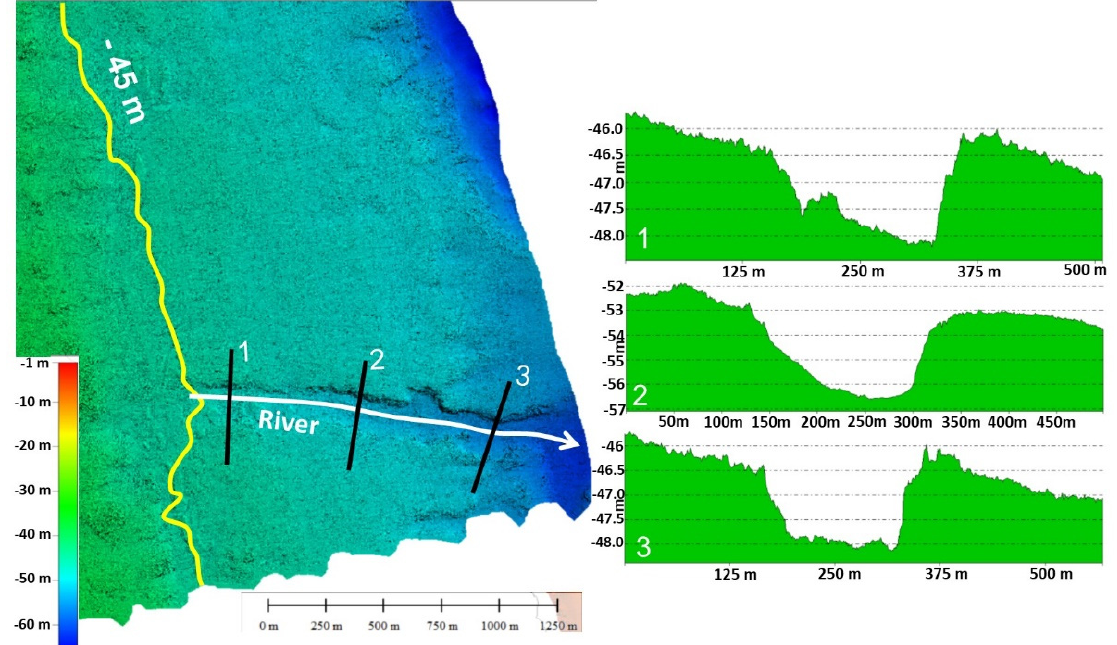
Figure 15. Distal portion of the southern sector. Profiles 1, 2, and 3 show the morphological variations from northwest to southeast of the main incision described in the area .